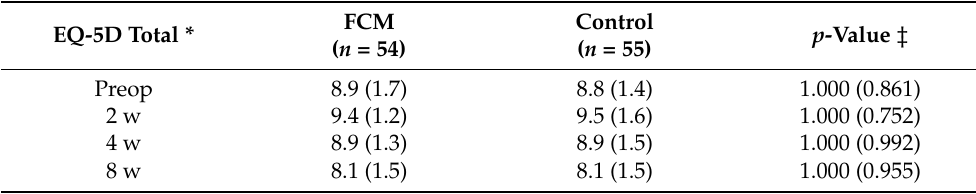
Table 3. Postoperative patient report QOL